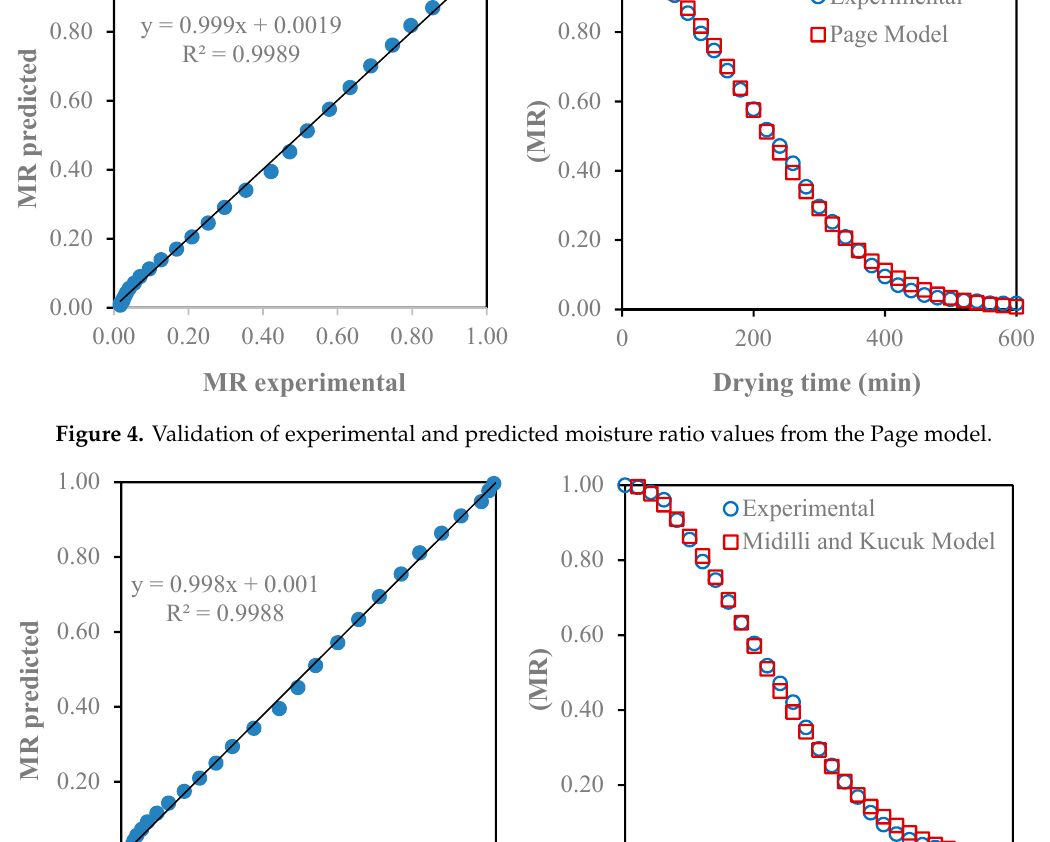
y = 0.999x + 0.0019 R² = 0.9989